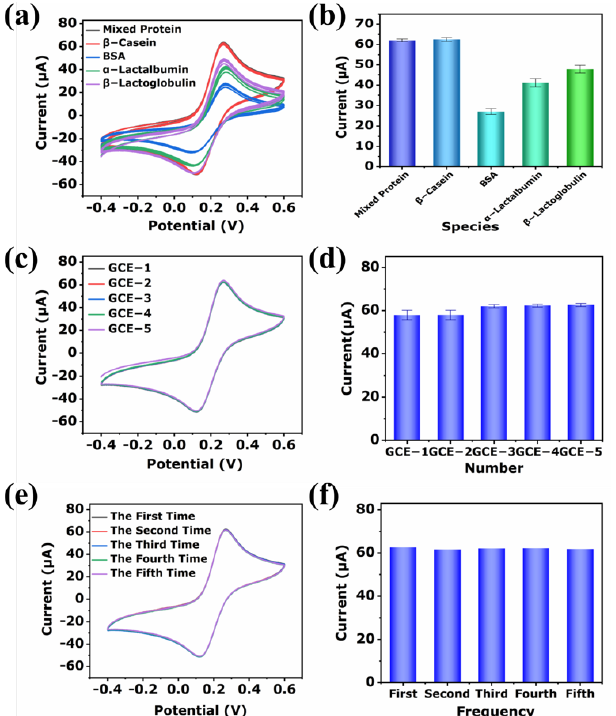
Figure 6. ( a ) CV of the selectivity of different protein adsorption electrodes to detect current and ( b ) selectivity histogram of CV, ( c ) CV of the stability of the detection current of five electrodes and ( d ) stability histogram of CV, ( e ) CV diagrams of the repeatability detected in parallel with one elec- trode and ( f ) repeatability histogram of